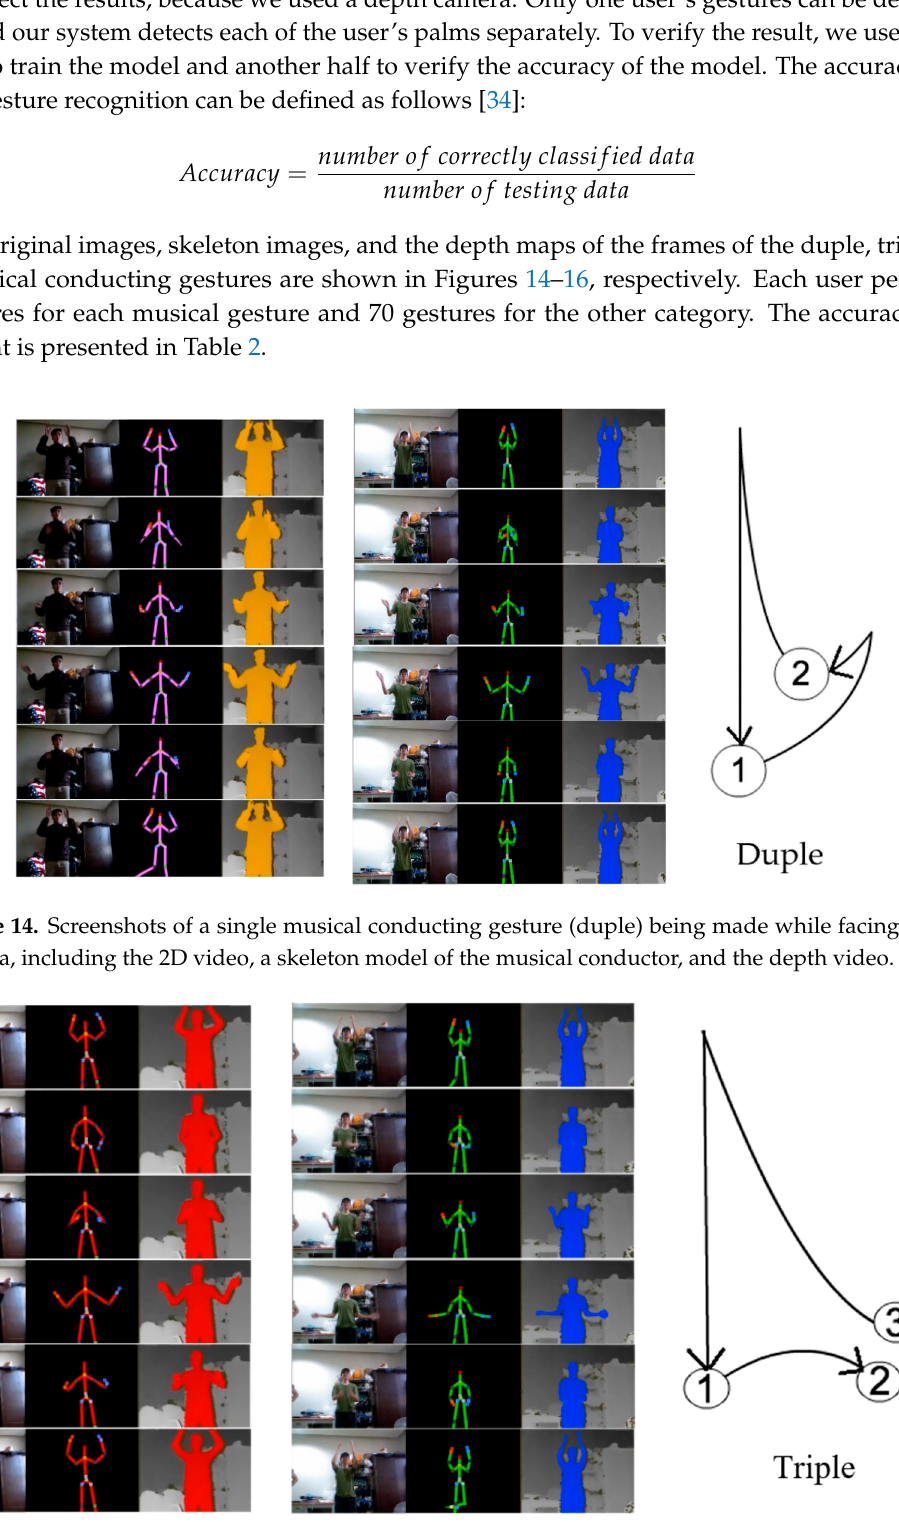
Figure 15. Screenshots of a single musical conducting gesture (triple) being made while facing the camera, including the 2D video, a skeleton model of the musical conductor, and the depth video.